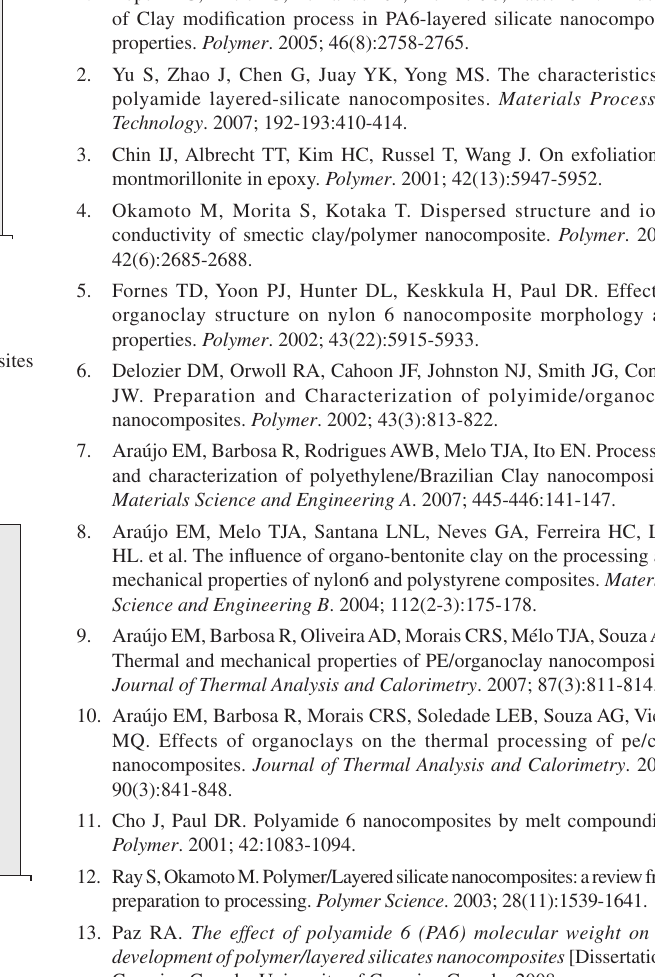
Figure 4. Izod impact strength of PA6 and its